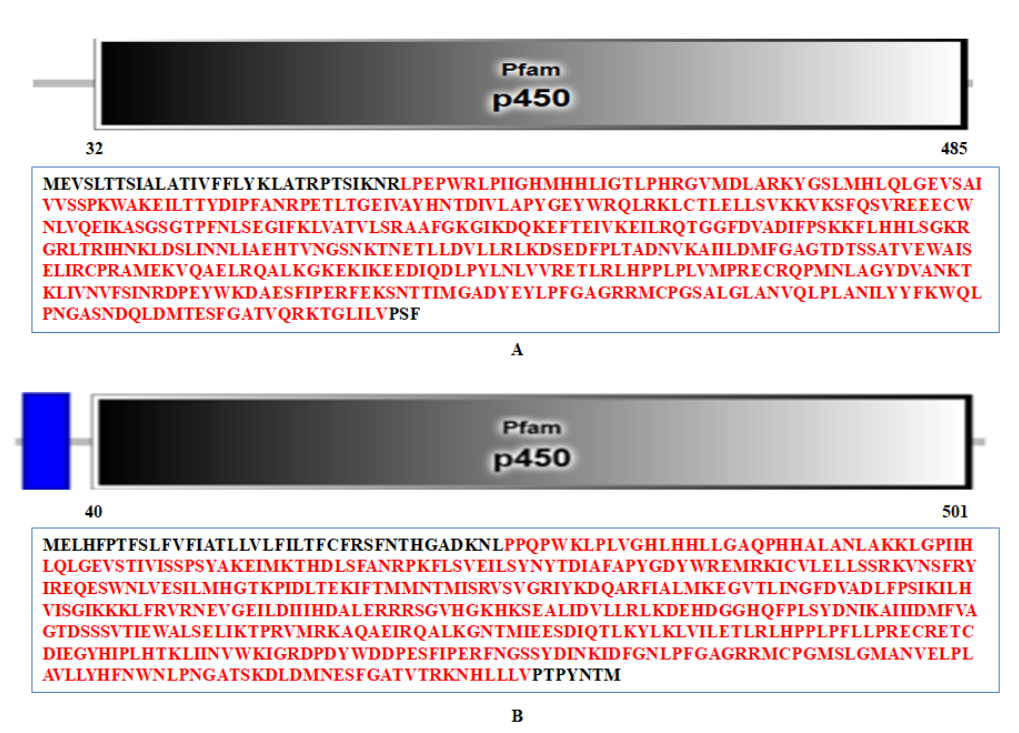
Figure A3. Domain prediction and amino acid sequences of Xs GAO1 ( A ) and Xs GAO2 ( B ). (Function domains shown in red).